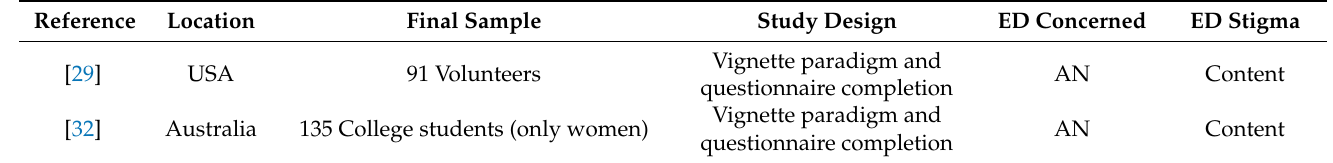
Table 1. Summary of studies included in the scoping